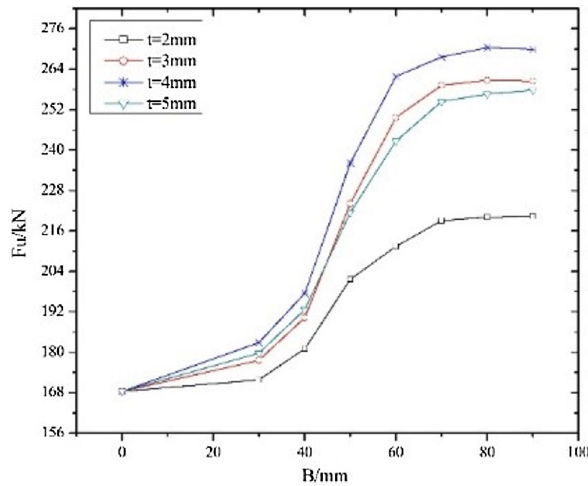
Fig. 19 Curves of F u – B relationship